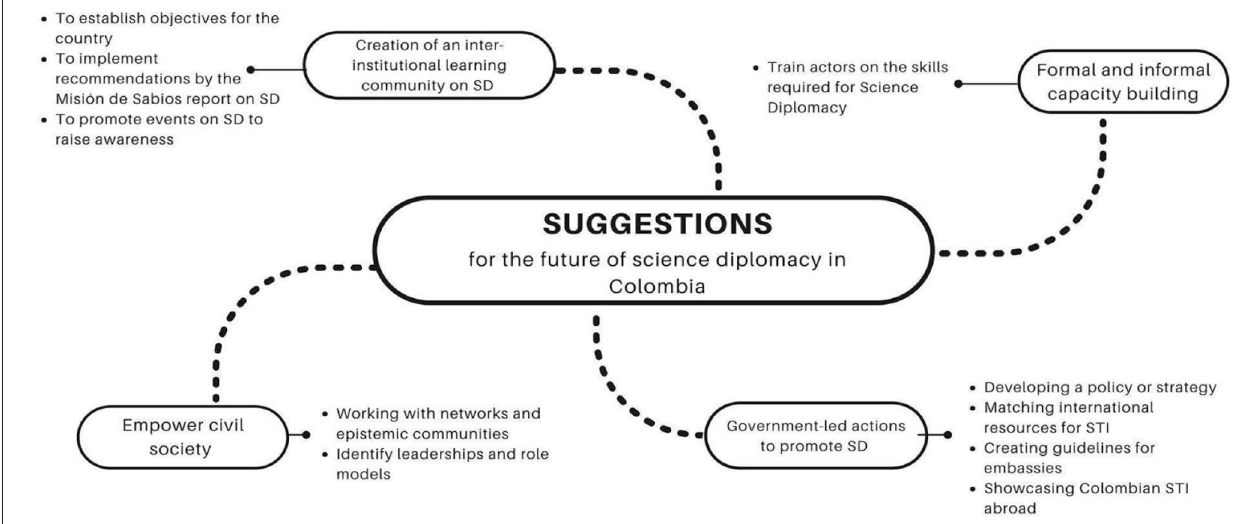
FIGURE 4 | Suggestions to strengthen the integration of actors. Participants were asked to provide suggestions on how to advance SD in Colombia. Categories are developed by the authors based on frequency and similarity between the answers